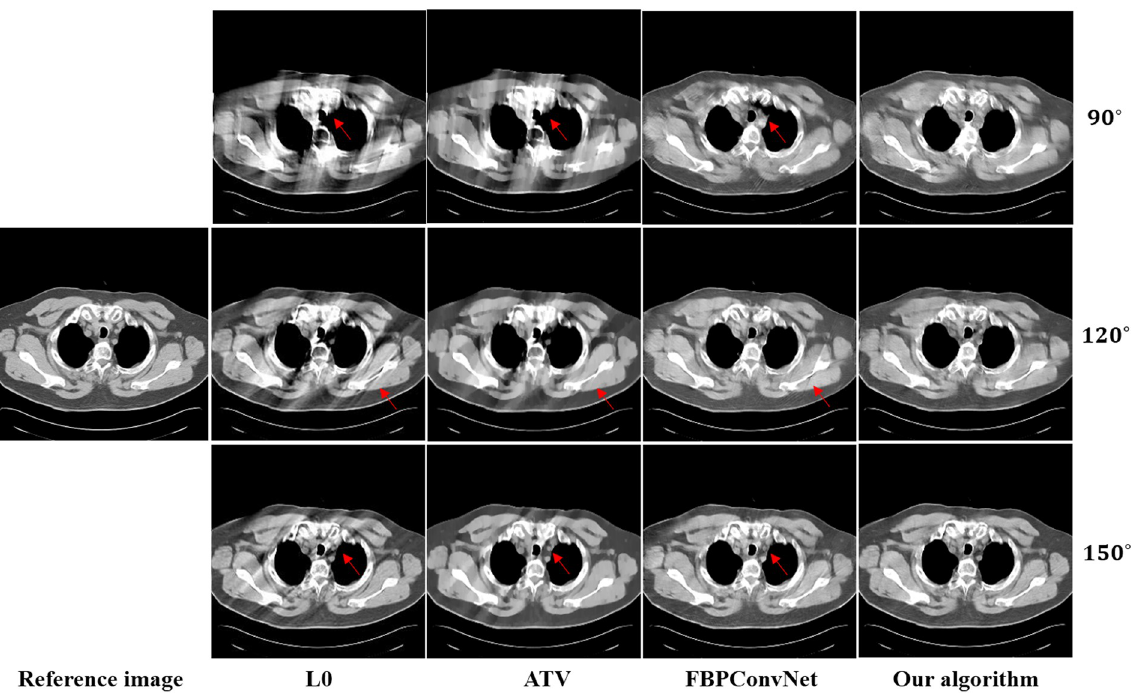
Fig 7. The reconstructed results of the chest image. The image on the first column is the reference image. The subsequent columns are the results reconstructed using L0 method, ATV method, FBPConvNet method and our algorithm. The images from top to bottom in each row are the results reconstructed for the scan ranges [0˚, 90˚], [0˚, 120˚] and [0˚, 150˚], respectively. The location of red arrows present some obvious artifacts, and the display window is [800 1200]